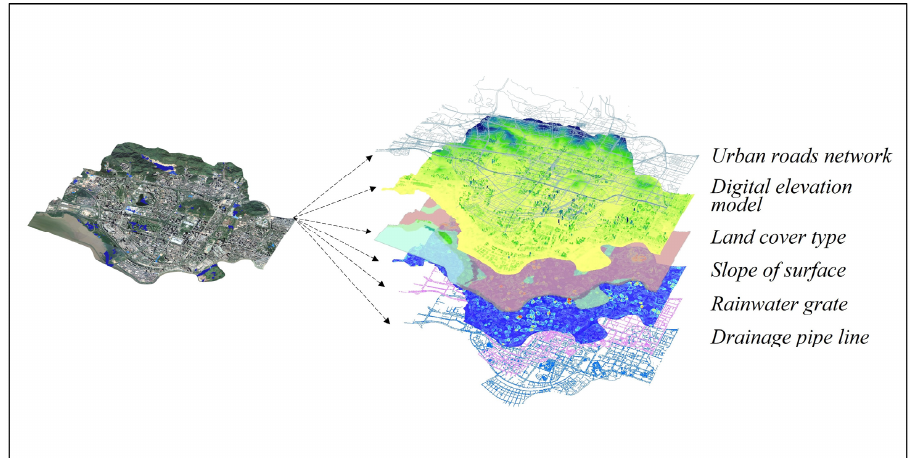
Figure 2. Building a multi-source data layer for a unified region (schematic diagram of the method).